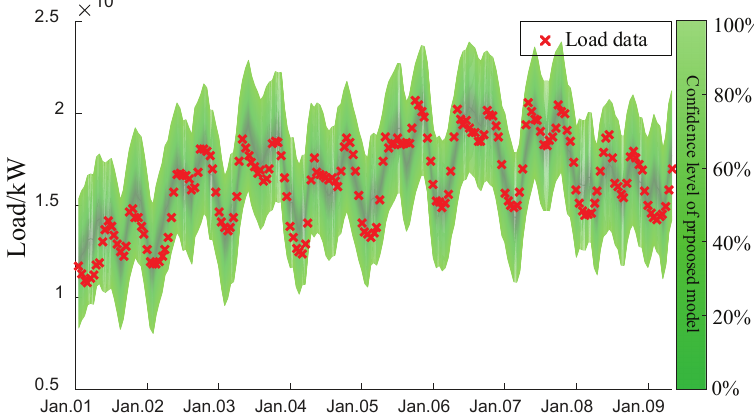
Figure 9. The former 200 h of results predicted by the proposed model.